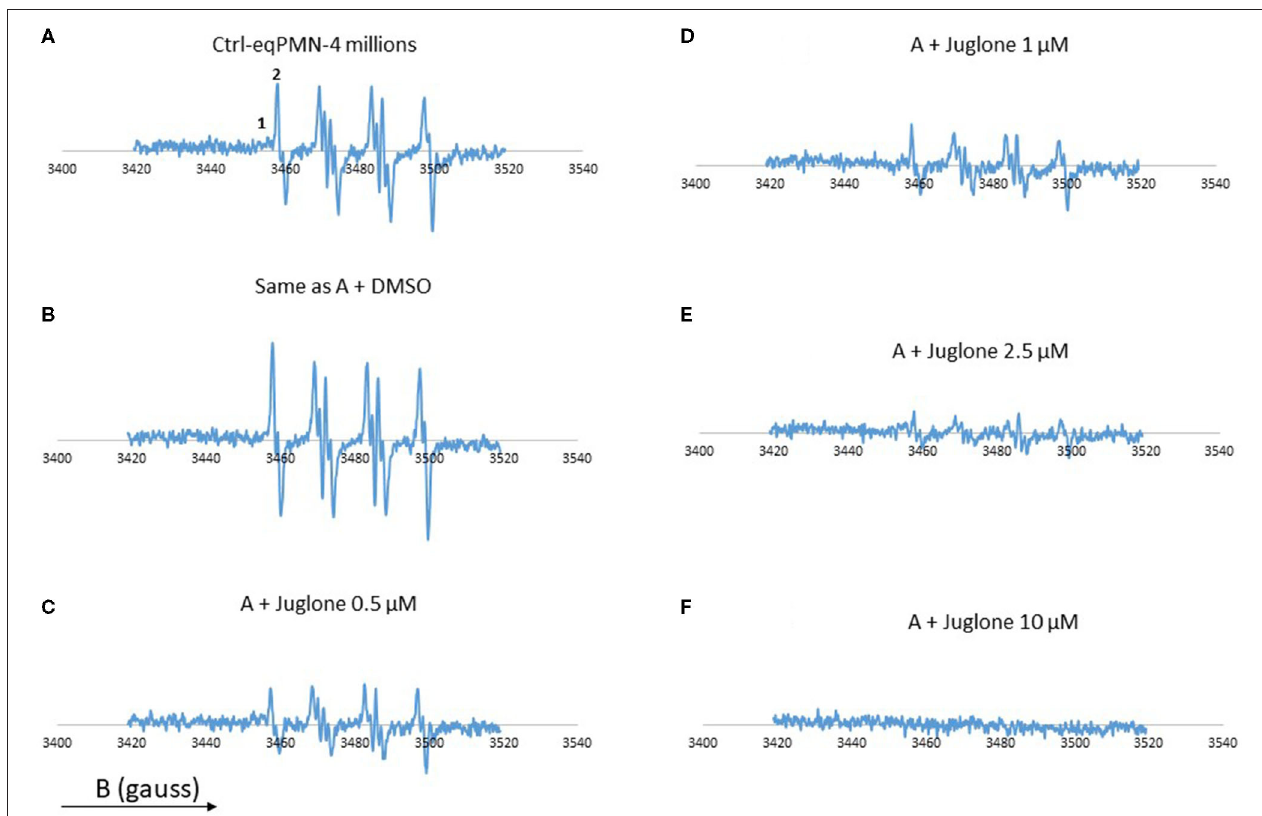
FIGURE 2 | Electron paramagnetic resonance (EPR) spectra from neutrophils (4 × 10 6 cells/ml) stimulated with phorbol myristate acetate (PMA, 5 × 10 − 7 M) in the presence of the spin trap 5,5 ′ -dimethyl-pyrroline- N -oxide (DMPO, 100mM). Scan (A) complete system which generates oxygen free radicals. Scan (B) same as (A) , but with 1% DMSO. Scan (C) same as (A) , but with 0.5 µ M juglone. Scan (D) same as (A) + juglone 1 µ M. Scan (E) same as (A) + juglone 2.5 µ M. Scan (F) same as (A) + juglone 10 µ M. Hyperfine splitting for scan (A) a H = 14 · 3G and a N = 14 · 87G. The results represent the mean of two experiments with two different cell batches. (1) DMPO–OH adduct. (2) DMPO–OOH adduct. The total number of scans is